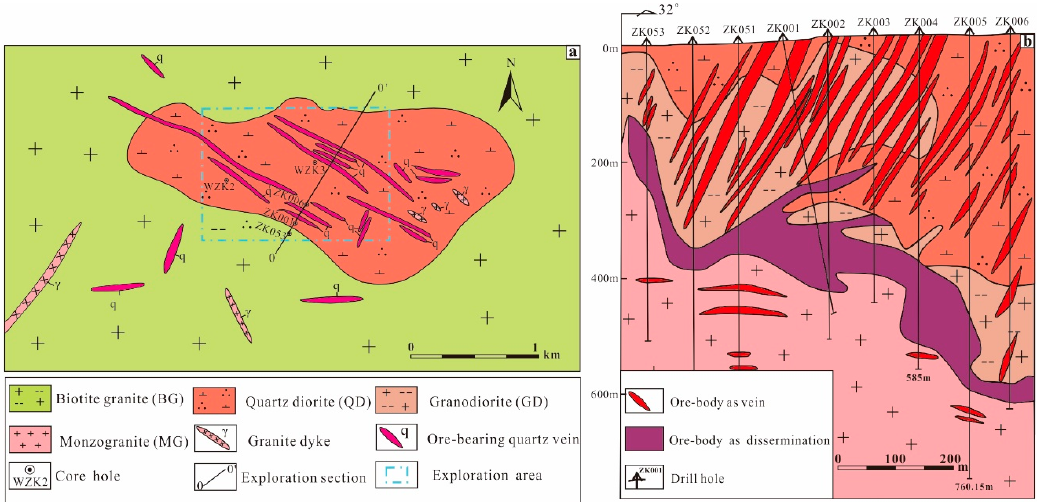
Figure 2. Geological sketch map ( a ) and exploration Section 0–0 ′ ( b ) of the Wulandele molybdenum deposit (after [1]).